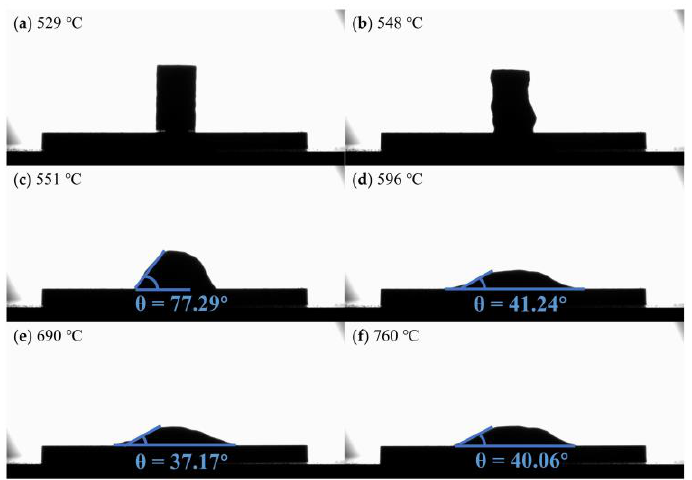
Figure 5. Images of the contact angle between flux #7 and alumina plate at different temperatures: